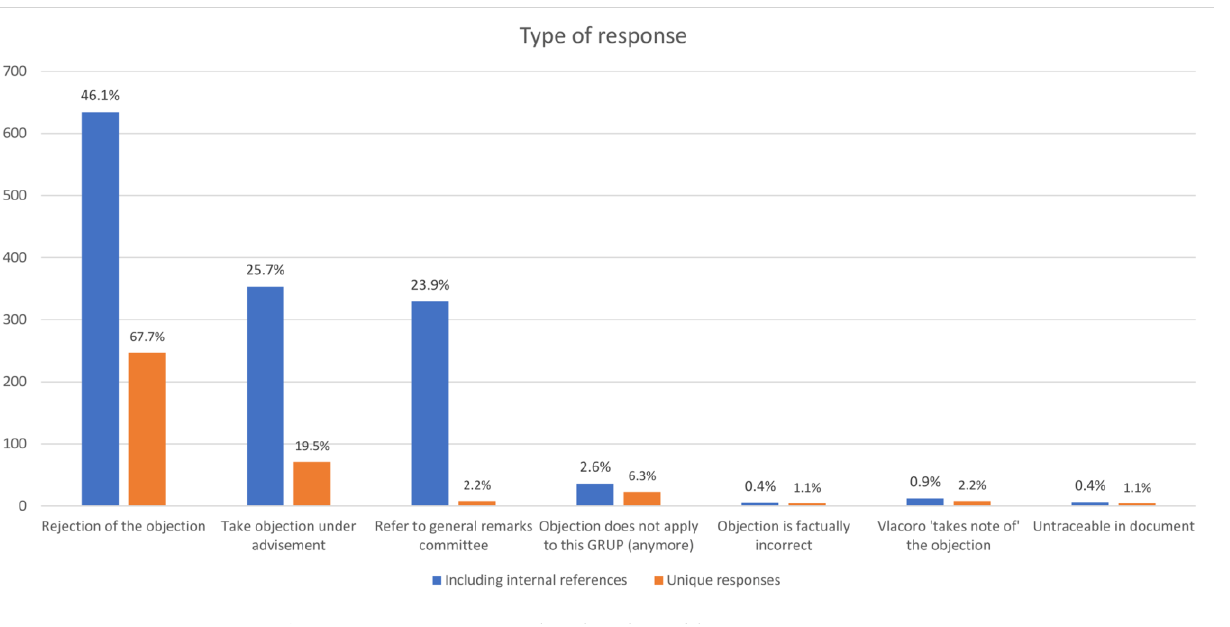
Figure 4. Responses considered in the public inquiry.